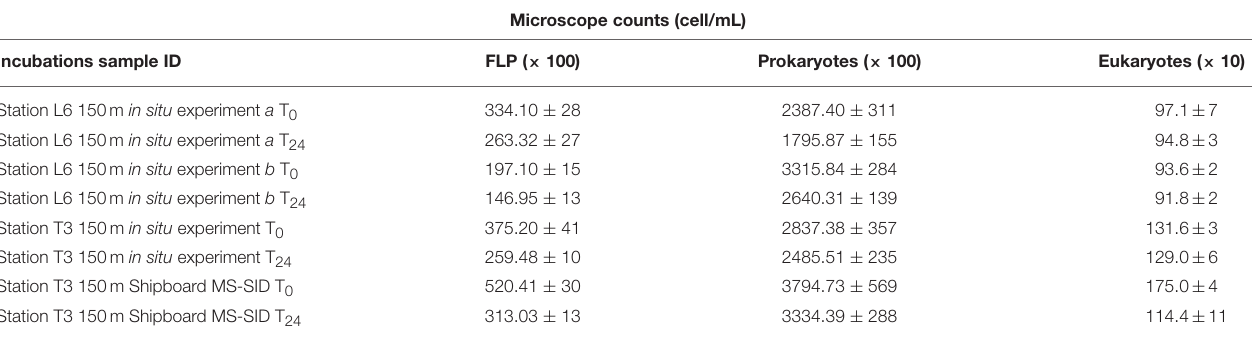
TABLE 2 | Average microscope cell counts for Time 0 and Time final (T f = 24h) for in situ incubation studies of protist grazing in the ETSP OMZ using the MS-SID and for the shipboard study using Niskin bottle water from 150m at Station T3 incubated in the MS-SID chamber. Microscope counts